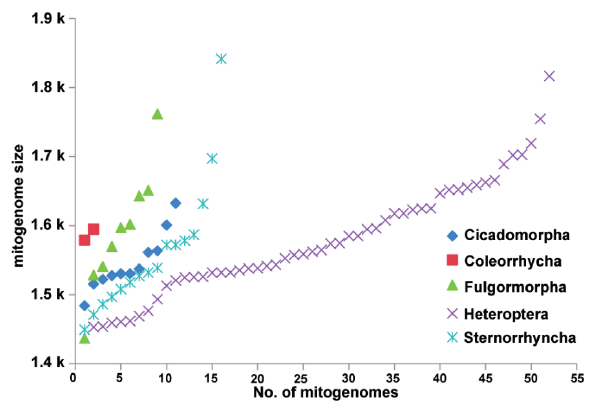
Figure 2. The size variation of mitogenomes from